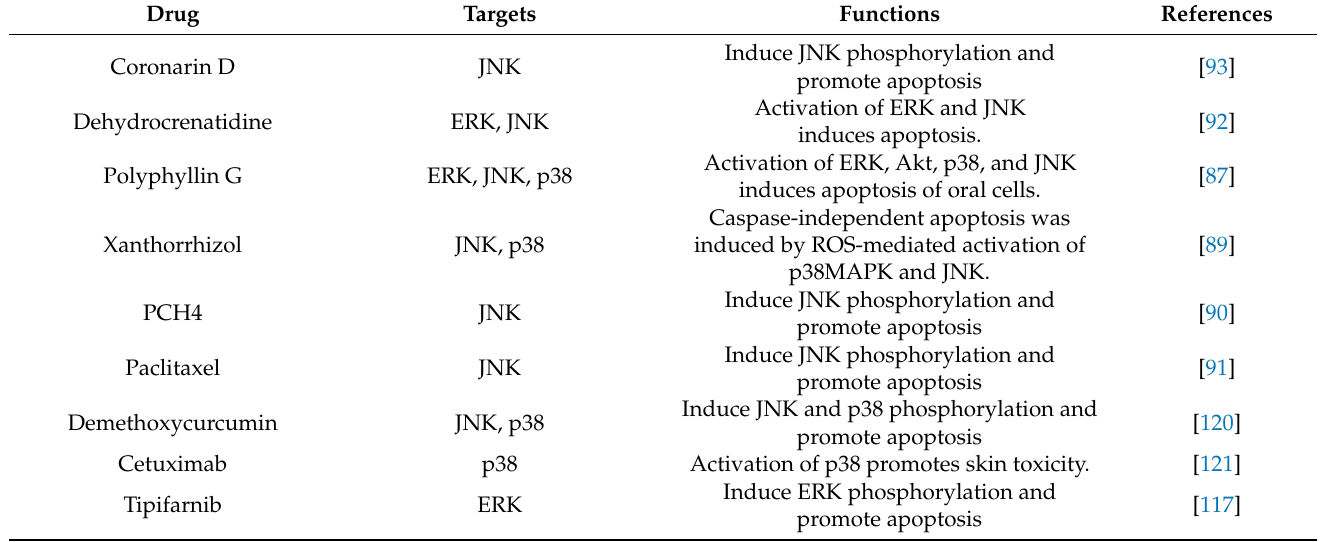
Table 2. Oral squamous cell carcinoma-related targeted therapeutic molecules and targets. Drug Targets